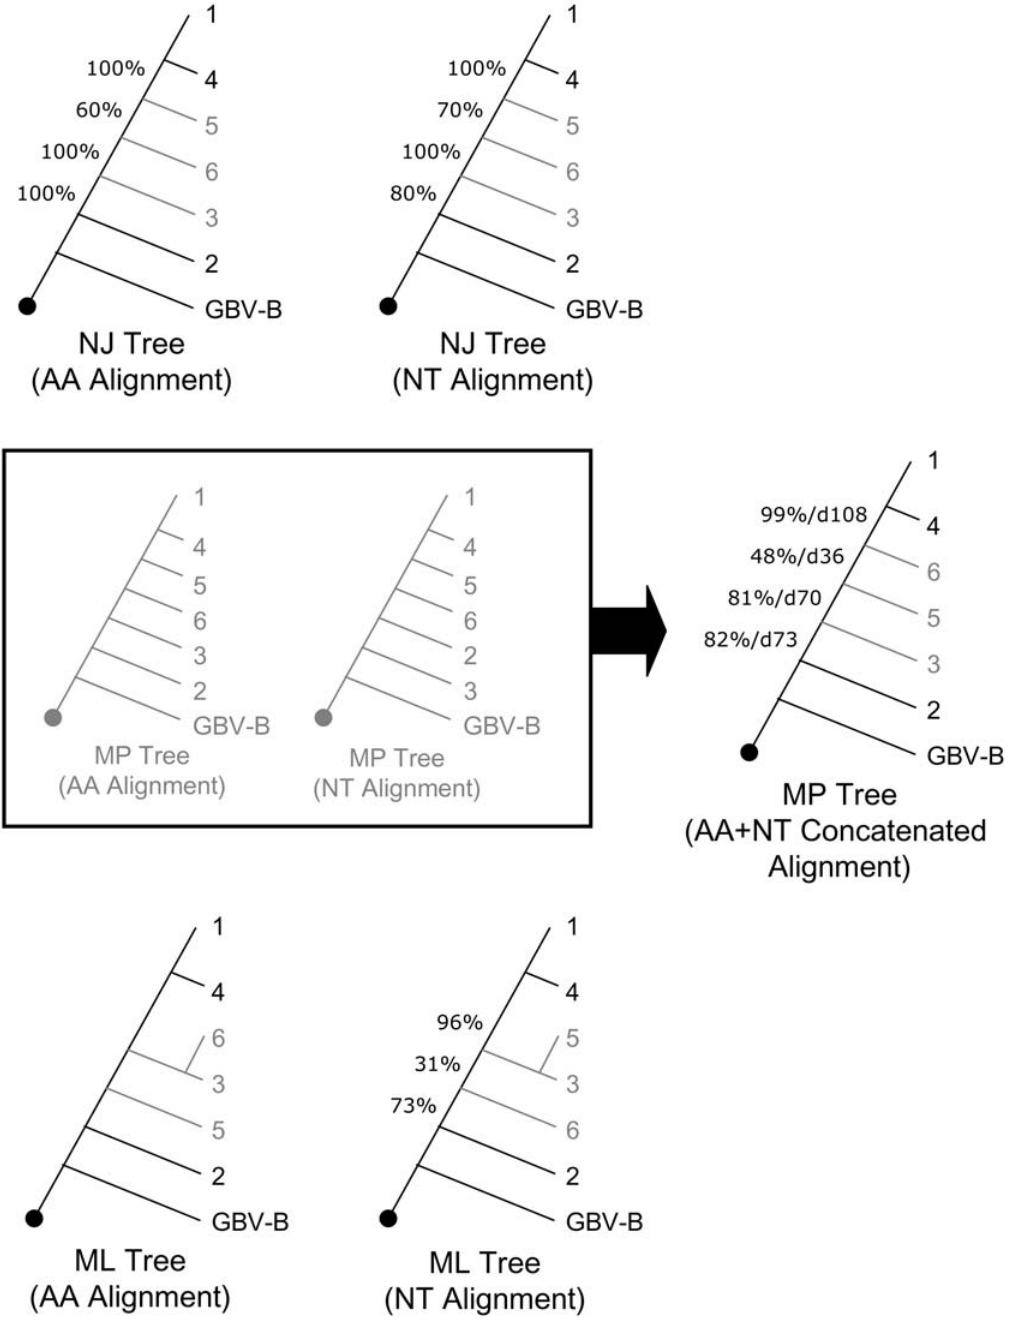
Figure 3. Rooted Neighbor-Joining (NJ), Maximum Parsimony (MP), and Maximum Likelihood (ML) cladograms depicting the evolution of the major hepatitis C virus genotypes. A nexus file of complete tree data is available online (Dataset S1). Numbers represent bootstrap support and Bremer decay indices. AA: amino acid sequences; NT: nucleotide sequences.